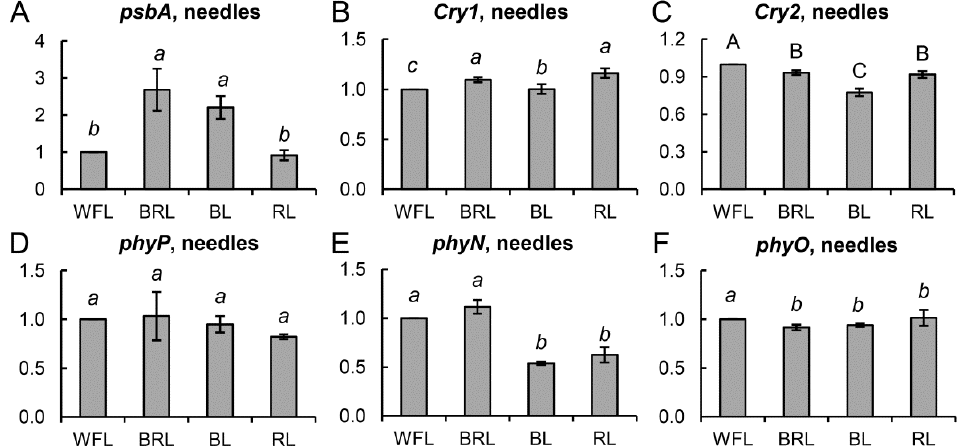
Figure 6. Effect of light quality on the transcript levels of different groups of genes in P. sylvestris needles. psbA ( A ), Cry1 ( B ), and Cry2 ( C ); and phyP ( D ), phyN ( E ), and phyO ( F ). The mRNA levels of the genes were expressed as the BRL, BL, RL/WFL ratio (fold change BRL, BL, RL/WFL). Values are the mean ± SE. Different capital letters denote statistically significant differences in the means at p < 0.05 (ANOVA followed by Duncan’s method). Different italic letters denote statistically significant differences in the means at p < 0.05 (Kruskal–Wallis ANOVA of the ranks followed by the Student-Newman – Keuls post hoc test).